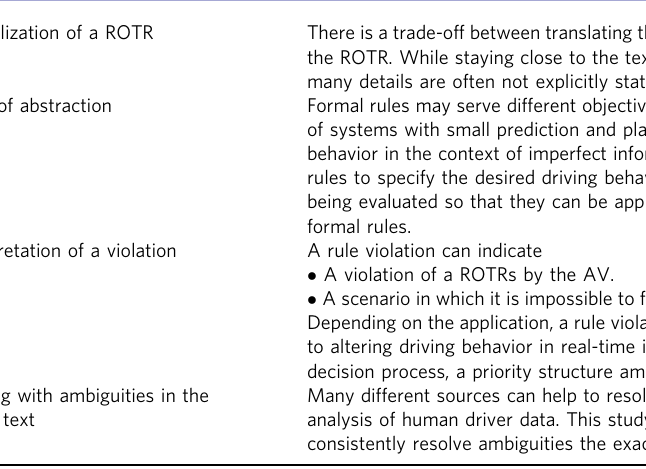
Table 3 Observations related to the development of formal rules from